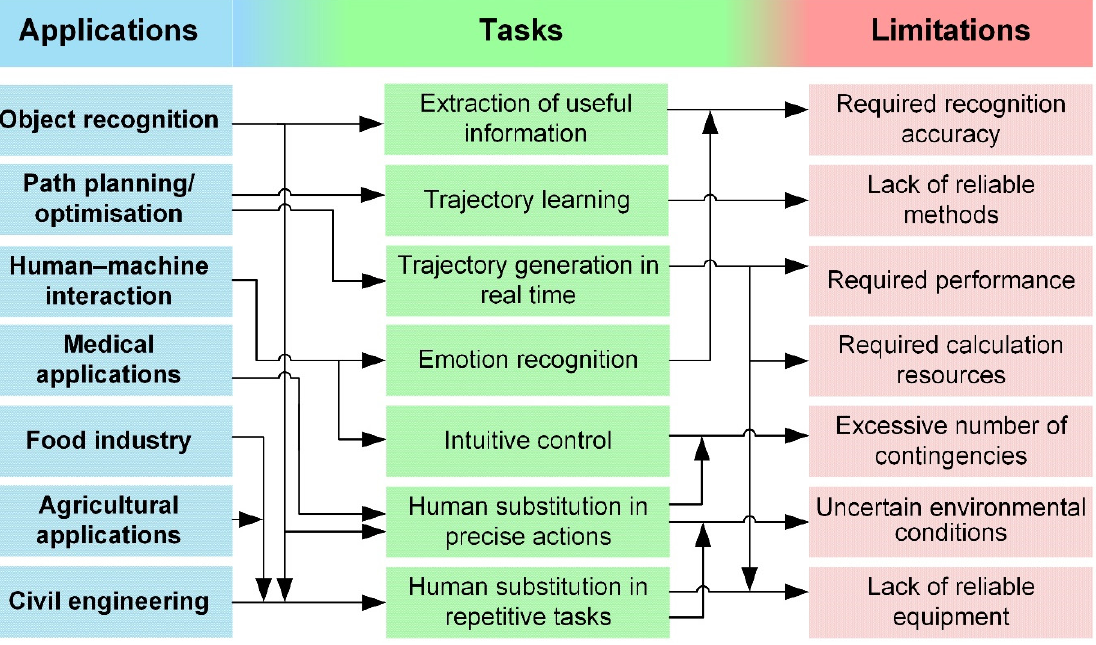
Figure 4. Relations between robot implementation areas, typical tasks and